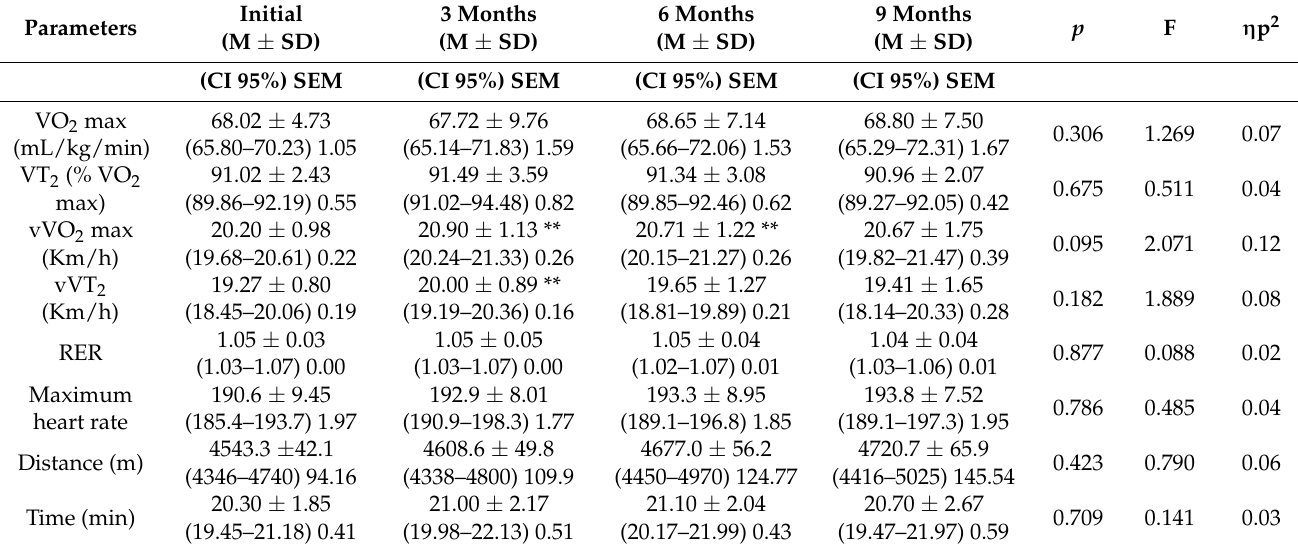
Table 3. Ergospirometric and performance parameters of the runners.